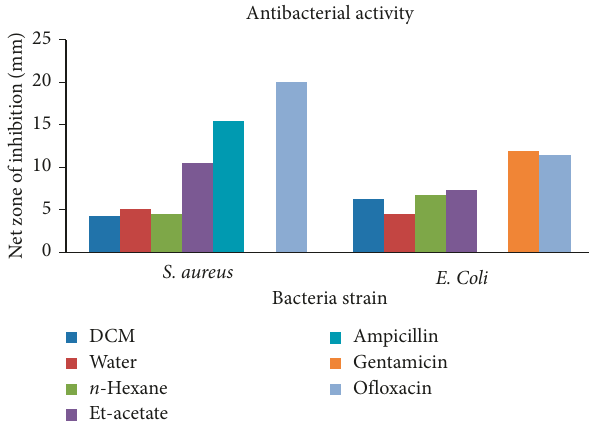
Figure 1: Inhibited zone shown by each fraction of Veronica biloba against bacterial